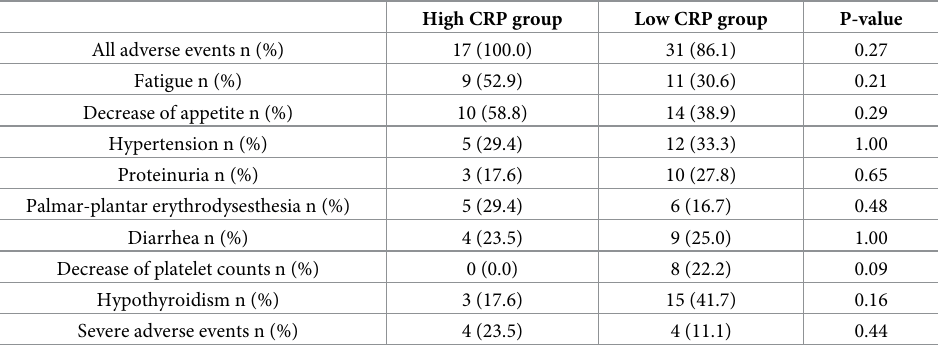
Table 5. Adverse